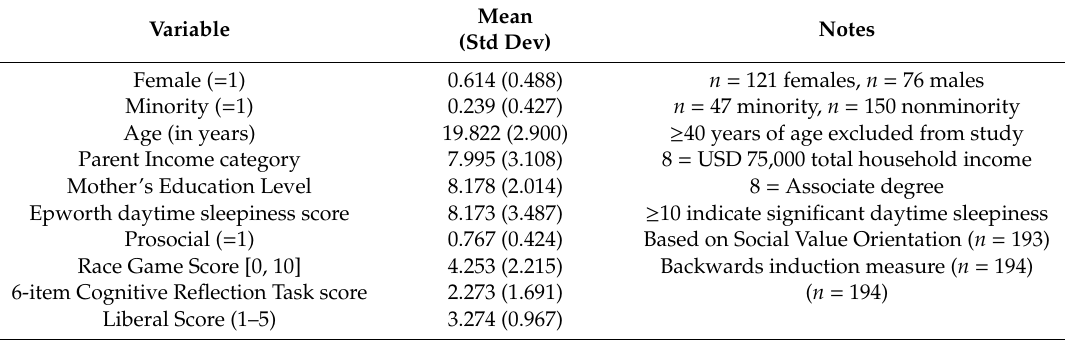
Table 1. Summary